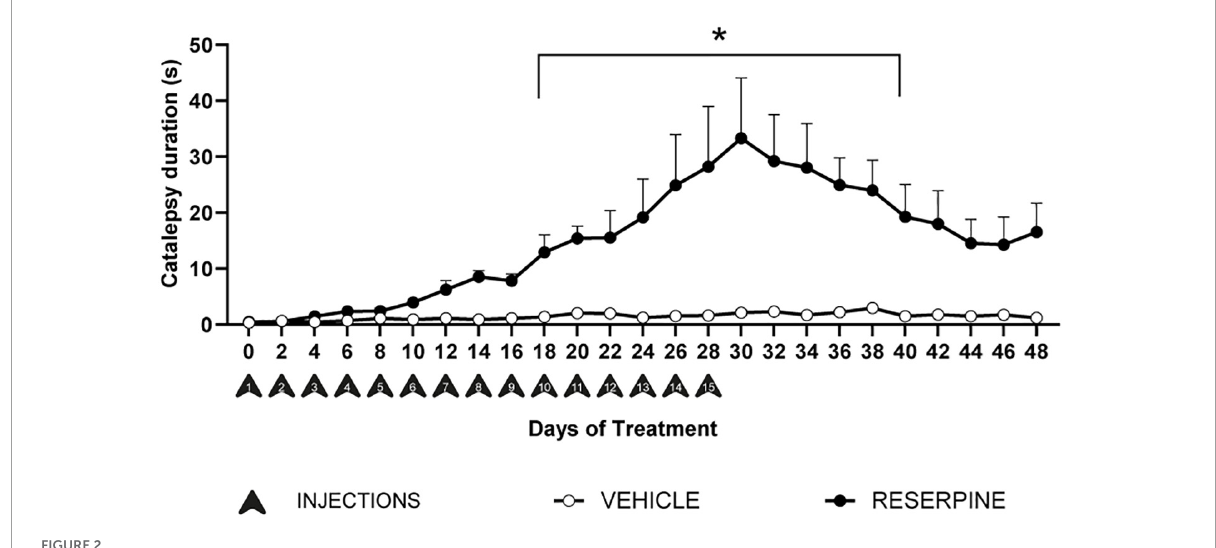
FIGURE2 Effects of repeated administration of 0.1 mg/kg reserpine on catalepsy behavior ( n = 9–10). Data are shown as mean + SEM.; * p < 0.05 comparing Reserpine and Vehicle groups (Two-way ANOVA with repeated measures followed by Bonferroni’s